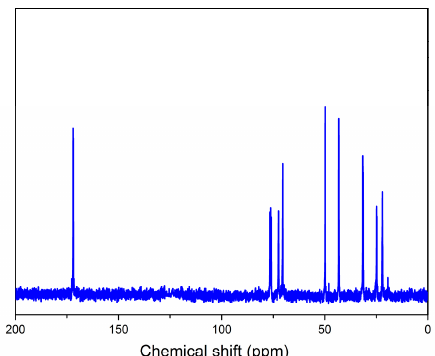
Figure 4. 13 C nuclear magnetic resonance (NMR) spectrum of HBP cleaved from the TiO 2 -HBP surface.